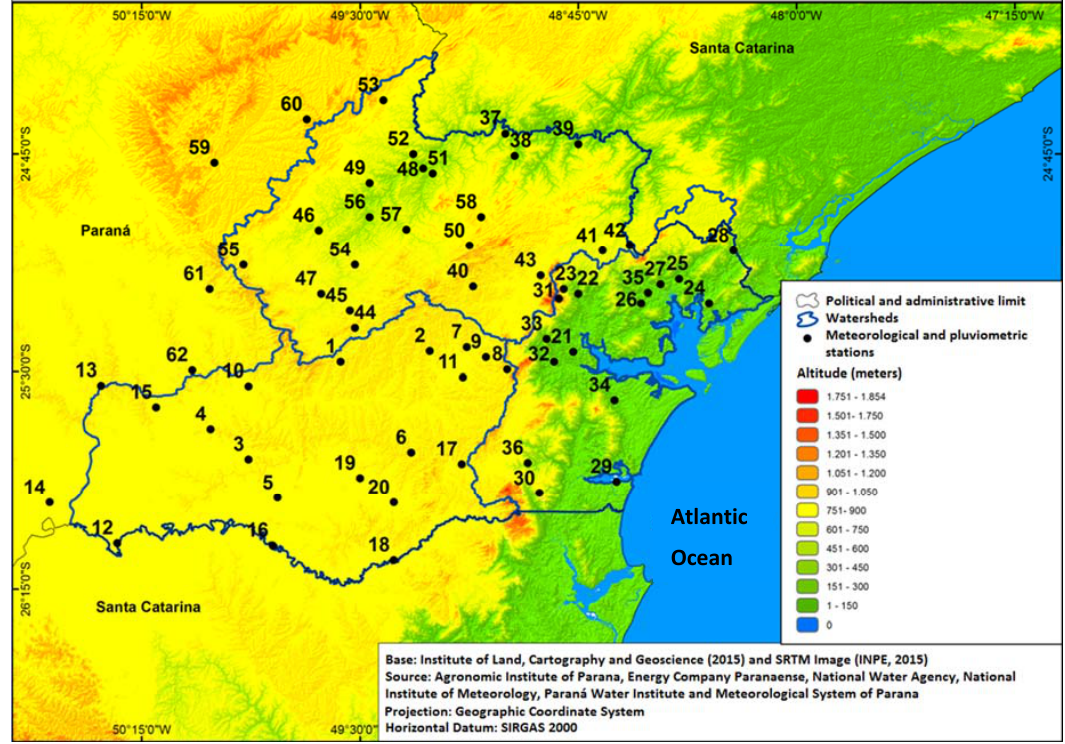
Figure 2. Location and hypsometric map of meteorological and pluviometric stations in the Alto Iguaçu, Ribeira and Litorânea watersheds, Paraná State, Brazil.